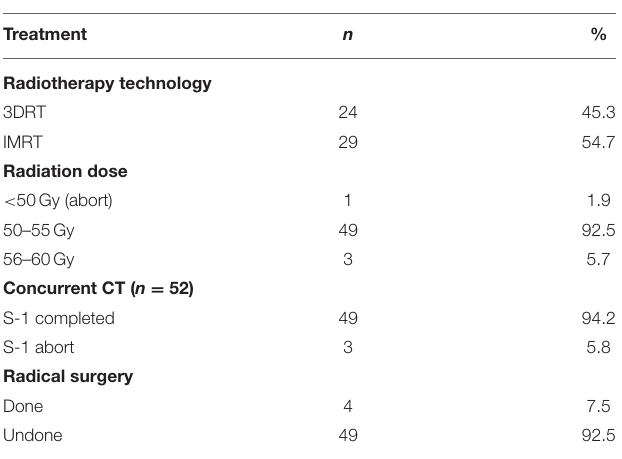
TABLE 4 | Treatment: cCRT ( n = 53).